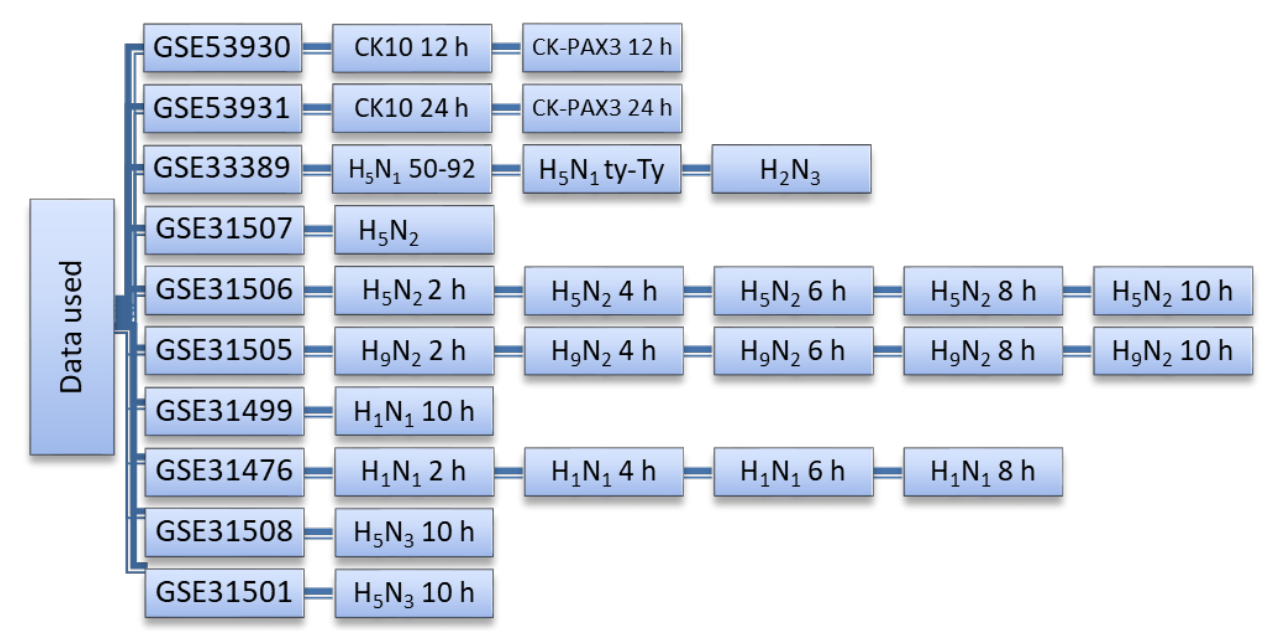
Figure 2. The datasets used and their corresponding viruses and sample collection times (post-infection). All samples are derived from lung tissue. H5N1-50-92 is a classical HPAI virus H5N1 strain (A/turkey/England/50-92/91) and H5N1-ty-Ty is a contemporary Eurasian lineage clade 2.2.1 H5N1 virus (A/turkey/Turkey/1/05).